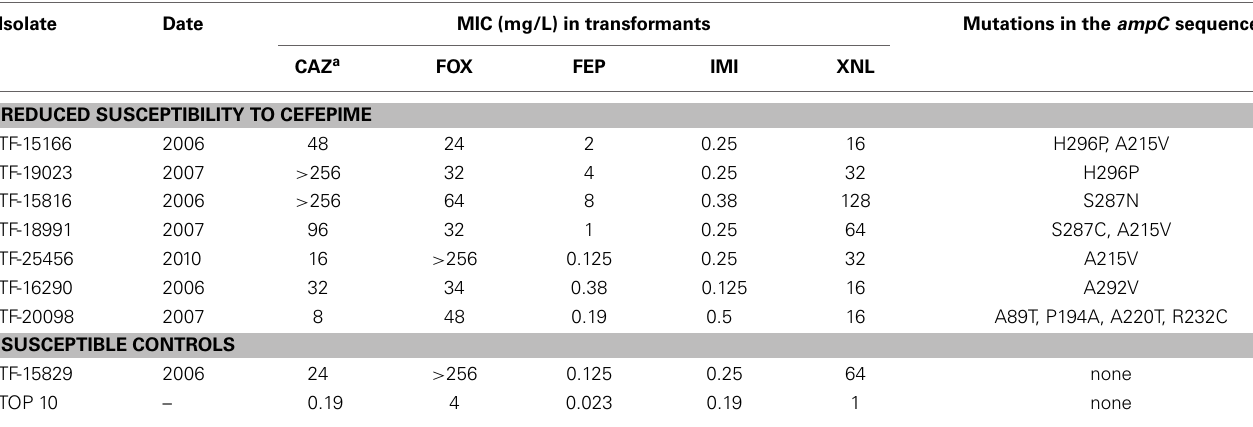
Table 2 | Characteristics of the 7 E. coli transformants representative of the strains presenting a reduced susceptibility to cefepime.